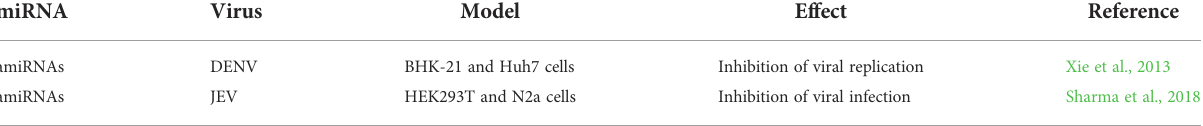
TABLE 3 Arti fi cial miRNAs against fl avivirus genomes.